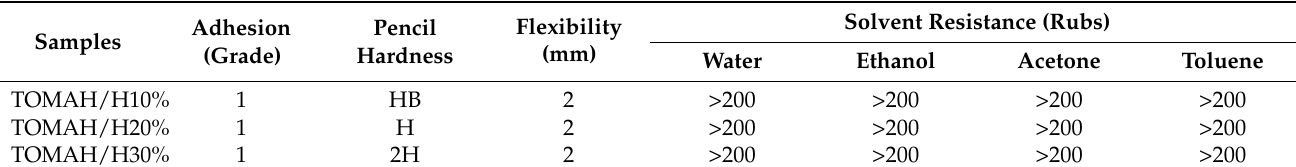
Table 5. Coating properties of the UV-cured TOMAH/H samples.